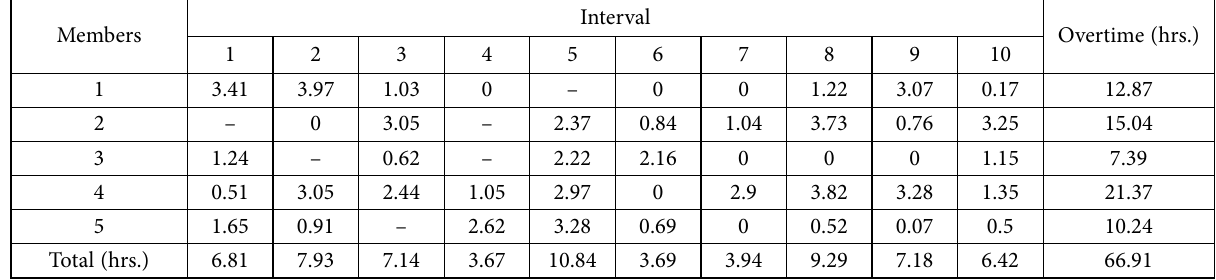
Table 13. The estimated members’ overtimes in each